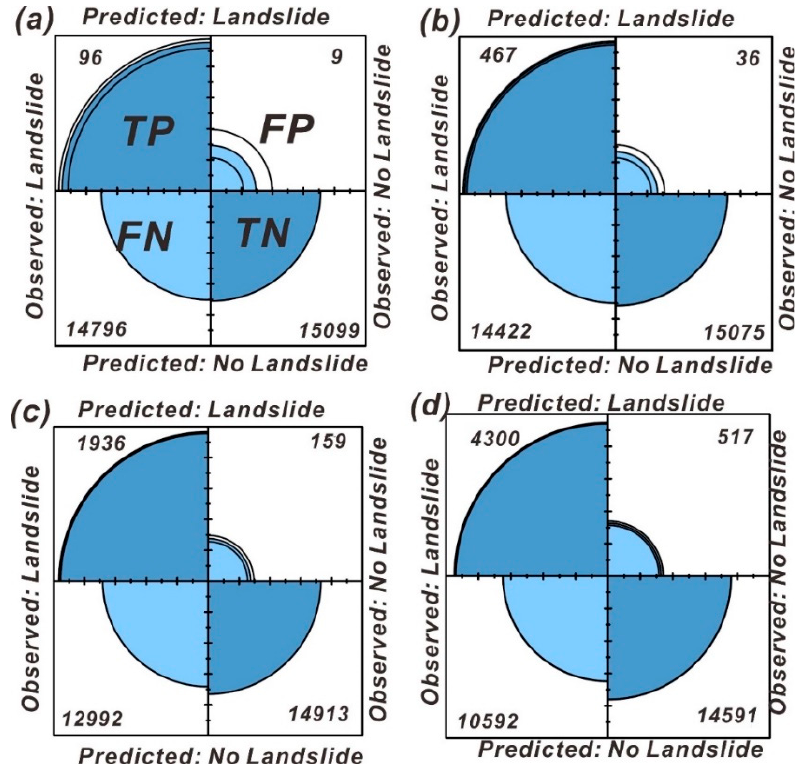
Figure 15. Fourfold plots summarizing the numbers of true positives (TP), true negatives (TN), false positives (FP), and false negatives (FN) for four rainfall events: ( a ) First event. ( b ) Second event. ( c ) Third event. ( d ) Fourth event.